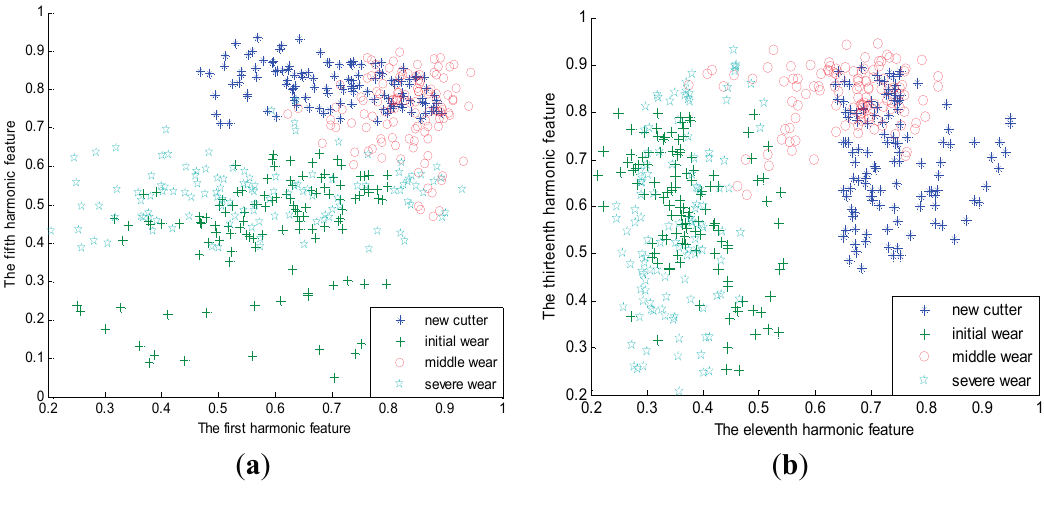
Figure 6. Spatial distributions of feature vectors for different tool wear categories. ( a ) The first and fifth harmonic feature; ( b ) The eleventh and thirteenth harmonic